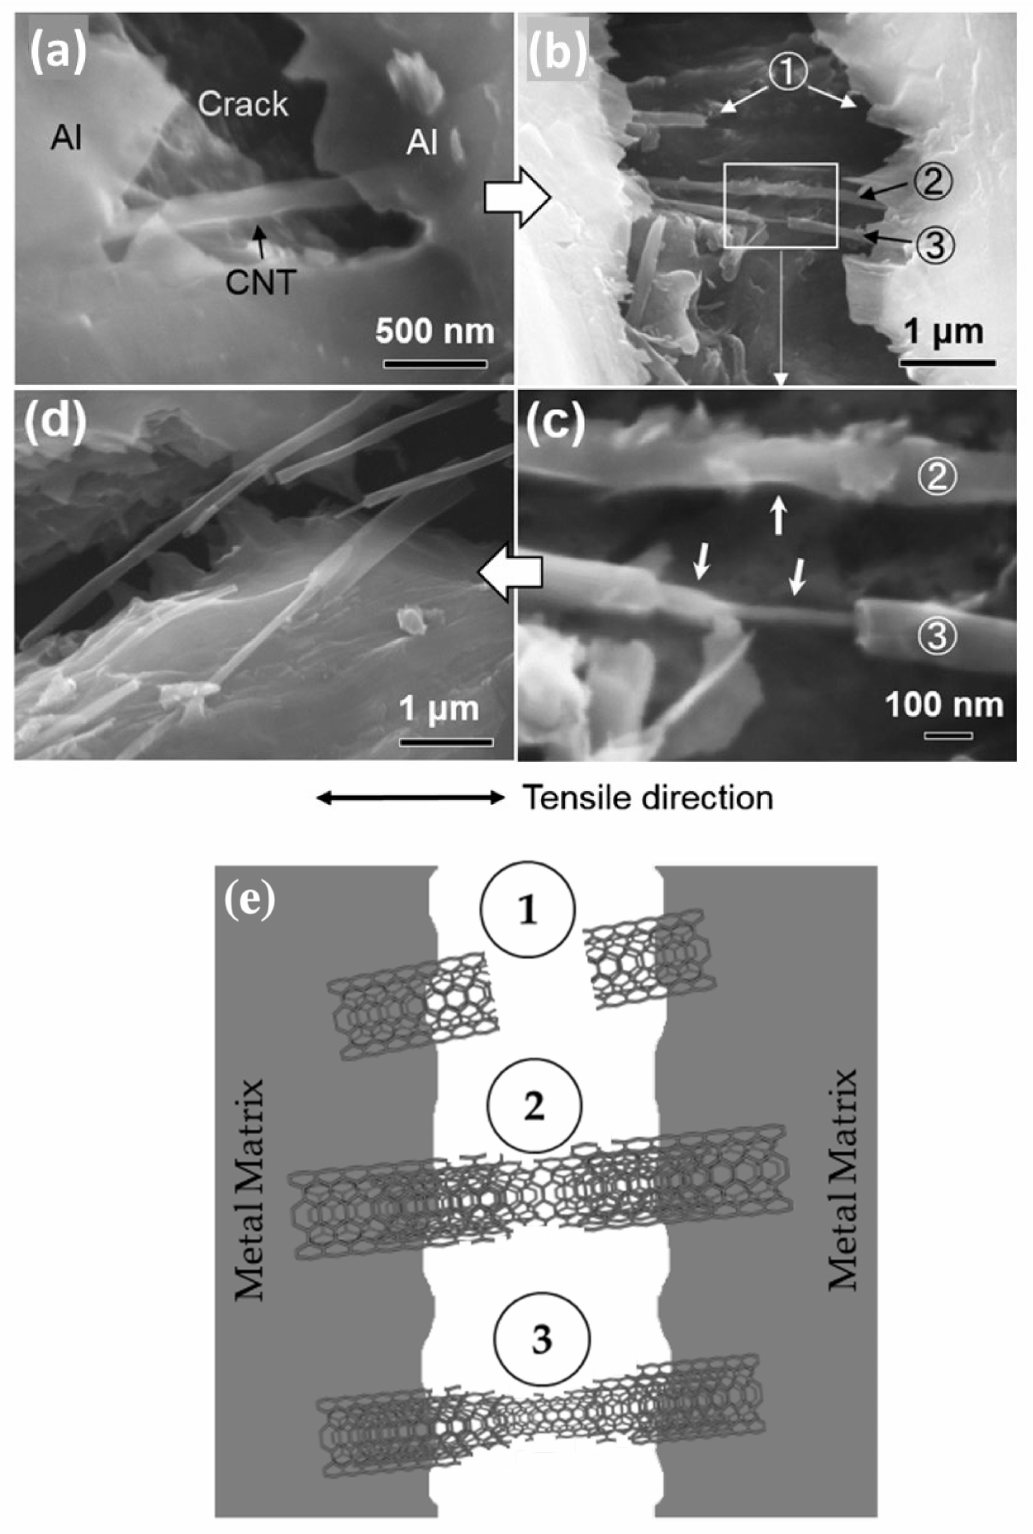
Figure 7. SEM images of the fracture process of the CNTs observed during the in situ tensile test: ( a ) CNT acting as a bridge, ( b , c ) CNTs marked as 1, 2 and 3 showing the different fracture processes at different magnifications, ( d ) fracture surface of the composite after tensile test, and ( e ) schematic representation of the different fractures. Adapted from [69] with permission from Elsevier,